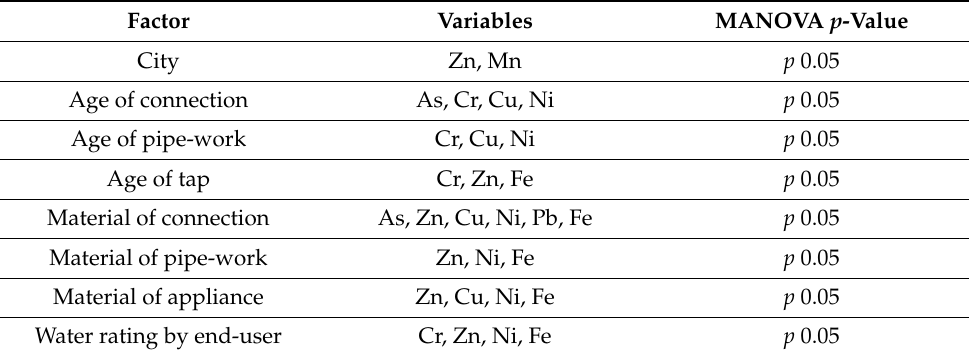
Table 7. Results of MANOVA for selected trace elements concentrations in tap